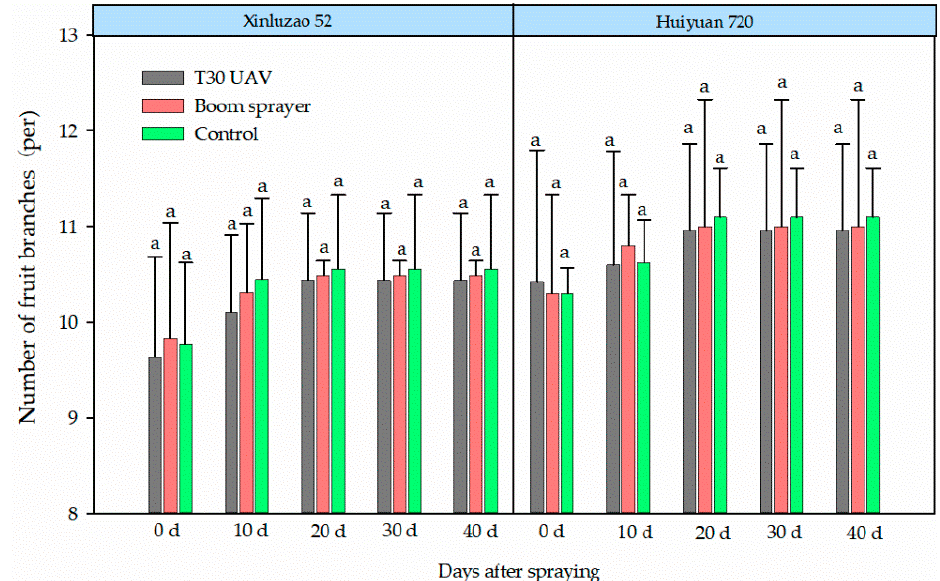
Figure 5. Effects of chemical topping agent sprayed by two sprayers on the number of cotton bolls in fruit branches. Different lowercase letters indicate significant differences between treatments at the 5% probability level ( p < 0.05).